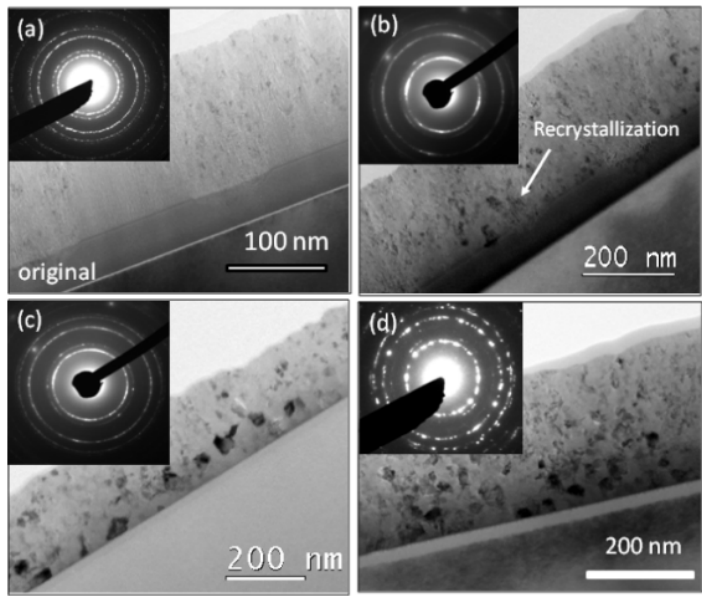
Figure 3. In situ TEM images with SAED insets of bilayer films of nanocrystalline cubic and amor- phous ZrO 2 , showing the crystal and microstructure evolution at ion fluences of ( a ) 0, original sample, ( b ) 3.13 × 10 14 ions/cm 2 , ( c ) 1.88 × 10 15 ions/cm 2 , and ( d ) 3.13 × 10 15 ions/cm 2 . Reproduced with permission from ref. [41].